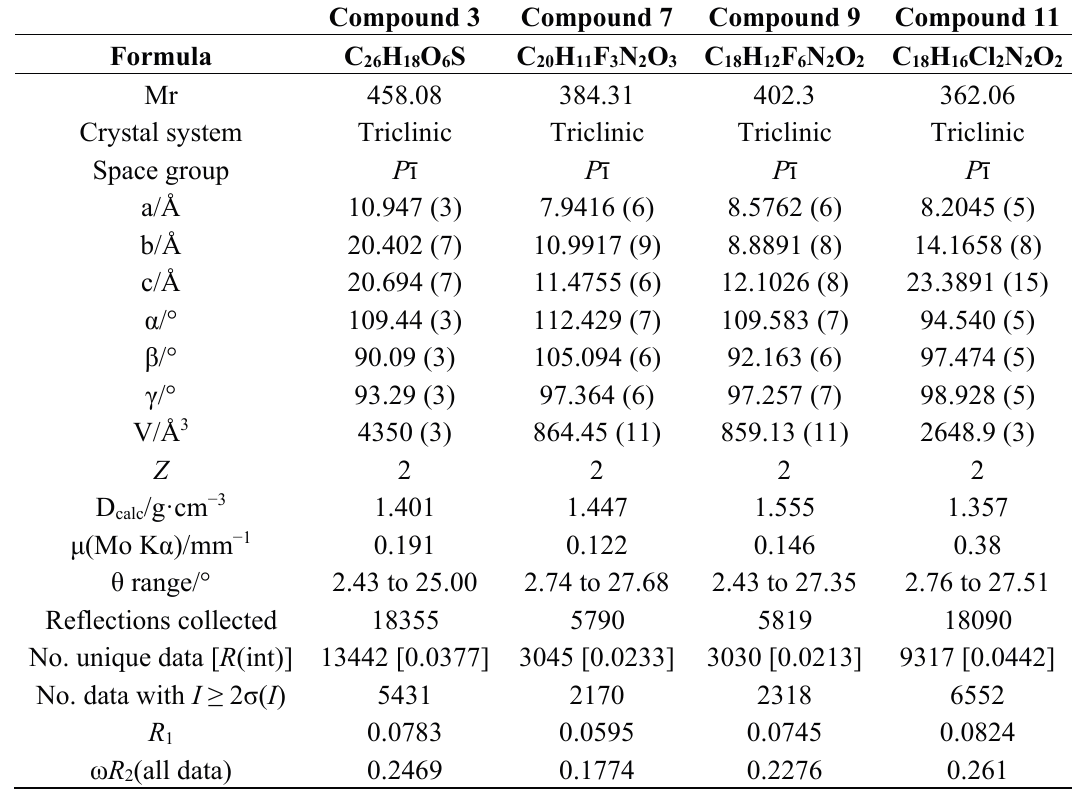
Table 4. Crystal data, data collection and structure refinement of compounds 3 , 7 , 9 and 11